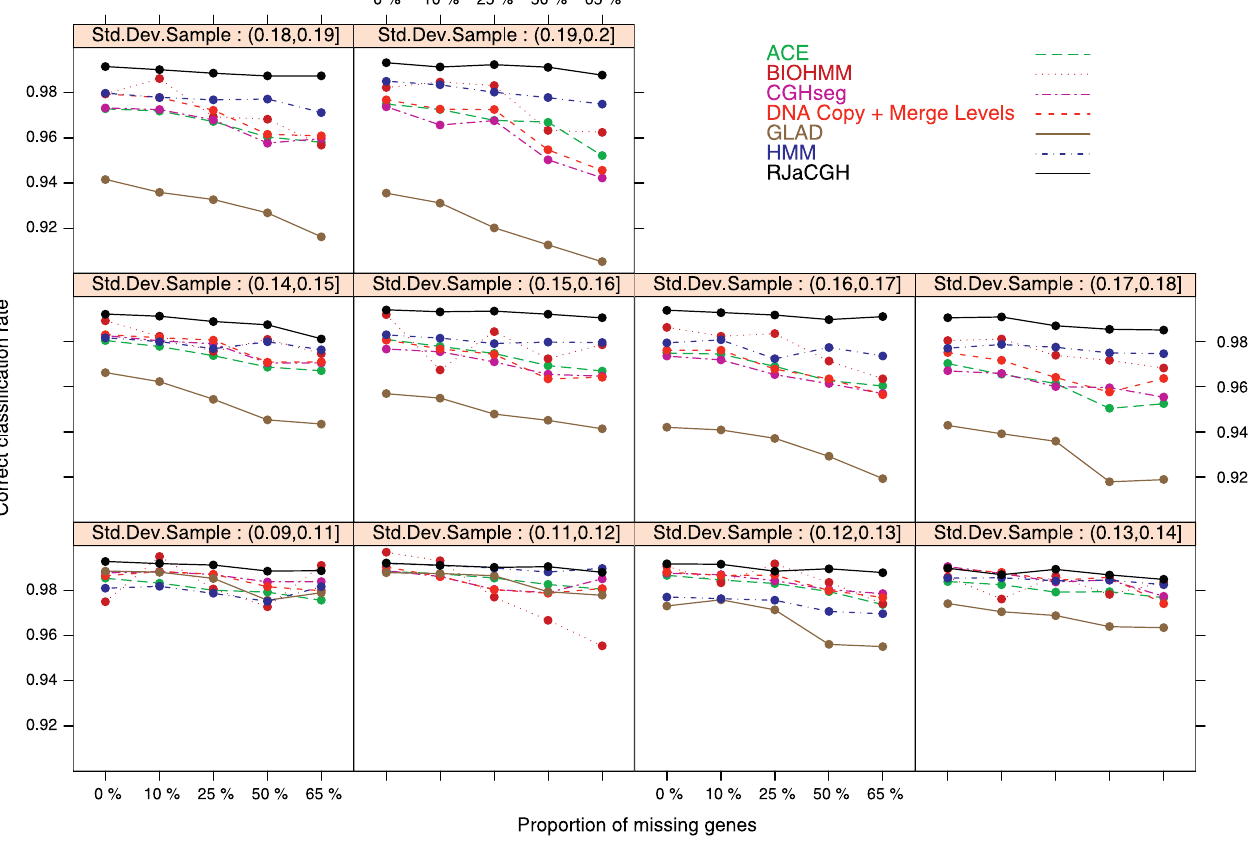
Figure 2. Joint Effects of Variability in Interprobe Distance and Noise on Correct Classification The same data are shown as those in Figure 1. The noise (standard deviation) of each sample is split into ten non-overlapping ranges, and each panel shows the mean correct classification success versus the proportion of missing probes (i.e., increasing levels of variance in interprobe distance). Each mean is based on approximately 50 samples. See Figure 1 for method references.